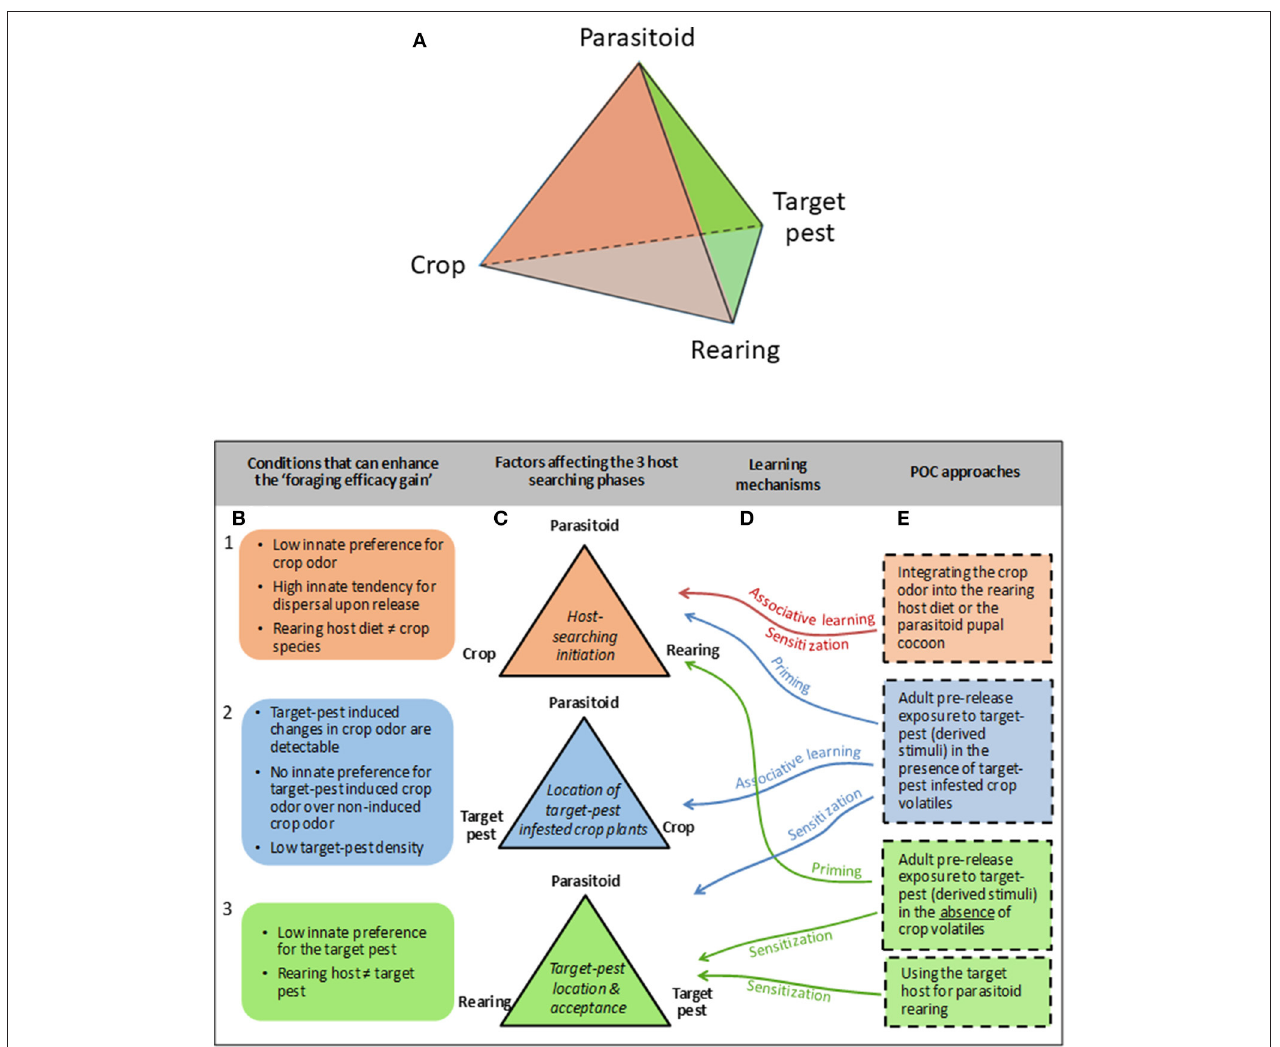
FIGURE 1 | Tetrahedron depicturing the interplay between the four main factors affecting parasitoid efficacy for target-pest control (A) . Each side of this tetrahedron corresponds to a different host-searching phase depicted by different colors (C) . In particular, the “host-searching initiation” phase is marked by the orange color; the “location of target pest infested crop plants” phase is marked by the blue color that is at the back of the tetrahedron and is not visible on the (A) ; and the “target-pest location and acceptance” phase is marked in green. Each host-searching phase can be associated with specific conditions that can enhance the “foraging efficacy gain” (B) , and can potentially be affected by different parasitoid olfactory conditioning (POC) approaches (E) mediated by associative and/or non-associative learning mechanisms (D)